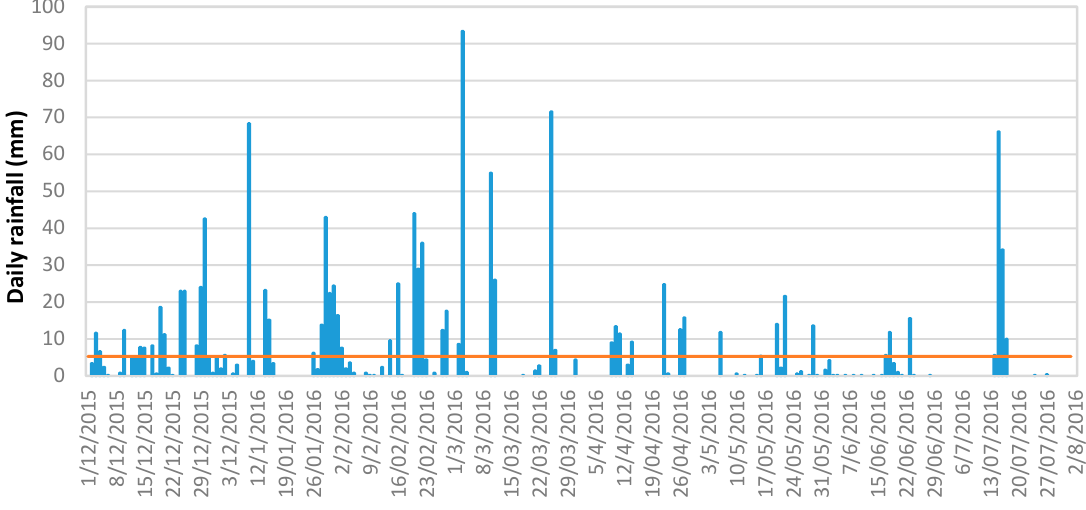
Figure 5. Daily rainfall in the city of S ã o Jos é from 01 / 12 / 2015 to 07 / 08 / Figure 5 . Daily rainfall in the city of São José from 01/12/2015 to 07/08/2016.